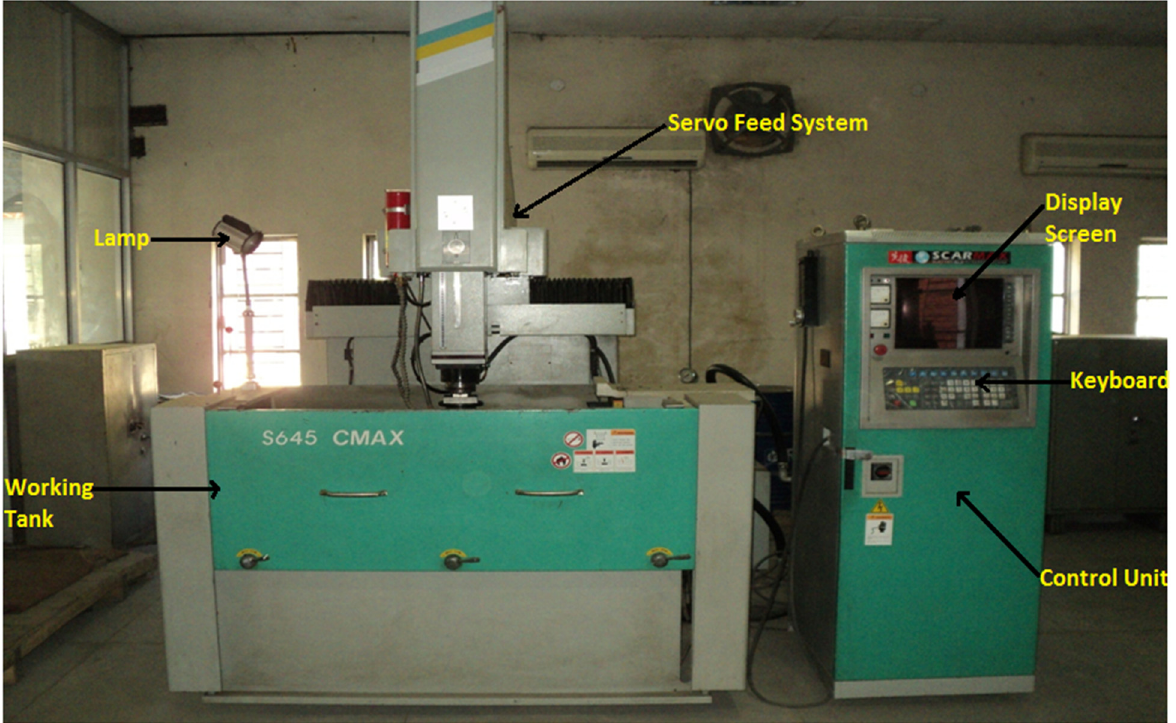
Figure 4: The schematic outlook of an EDM.